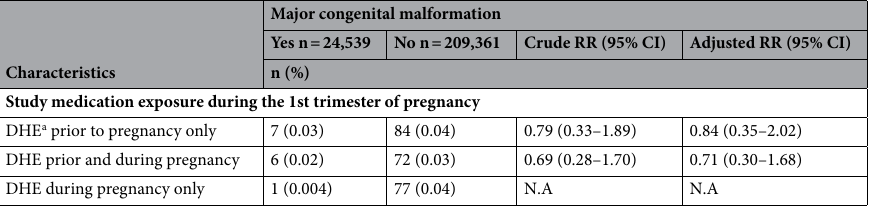
Table 9. Association between DHE exposure before or during the 1st trimester and the risk of major congenital malformations by categories of DHE exposure. Adjusted for all variables included in Table 4. a Dihydroergotamine.